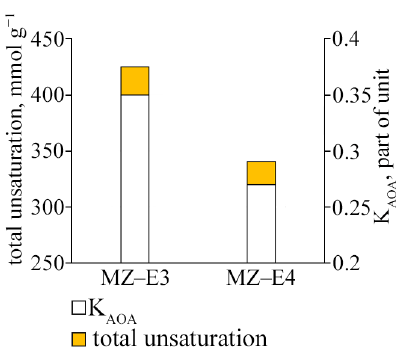
Figure 6. Antioxidant activity coefficient and fatty acid unsaturation of Vischeria vischeri strains (MZ–E3; MZ–E4). Medium: BBM; culture volume: 250 mL; incubation time: 25 days; M ± S.E., n = 3.